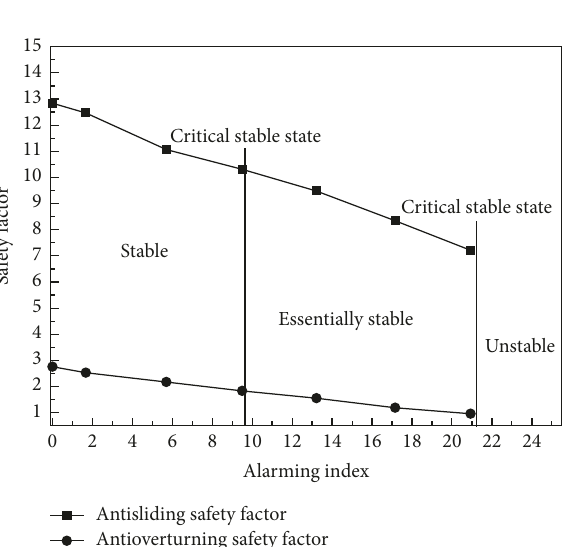
Figure12:Curveofalarmingindex-damagestabilityoftheretaining wall (damage in the backfill).